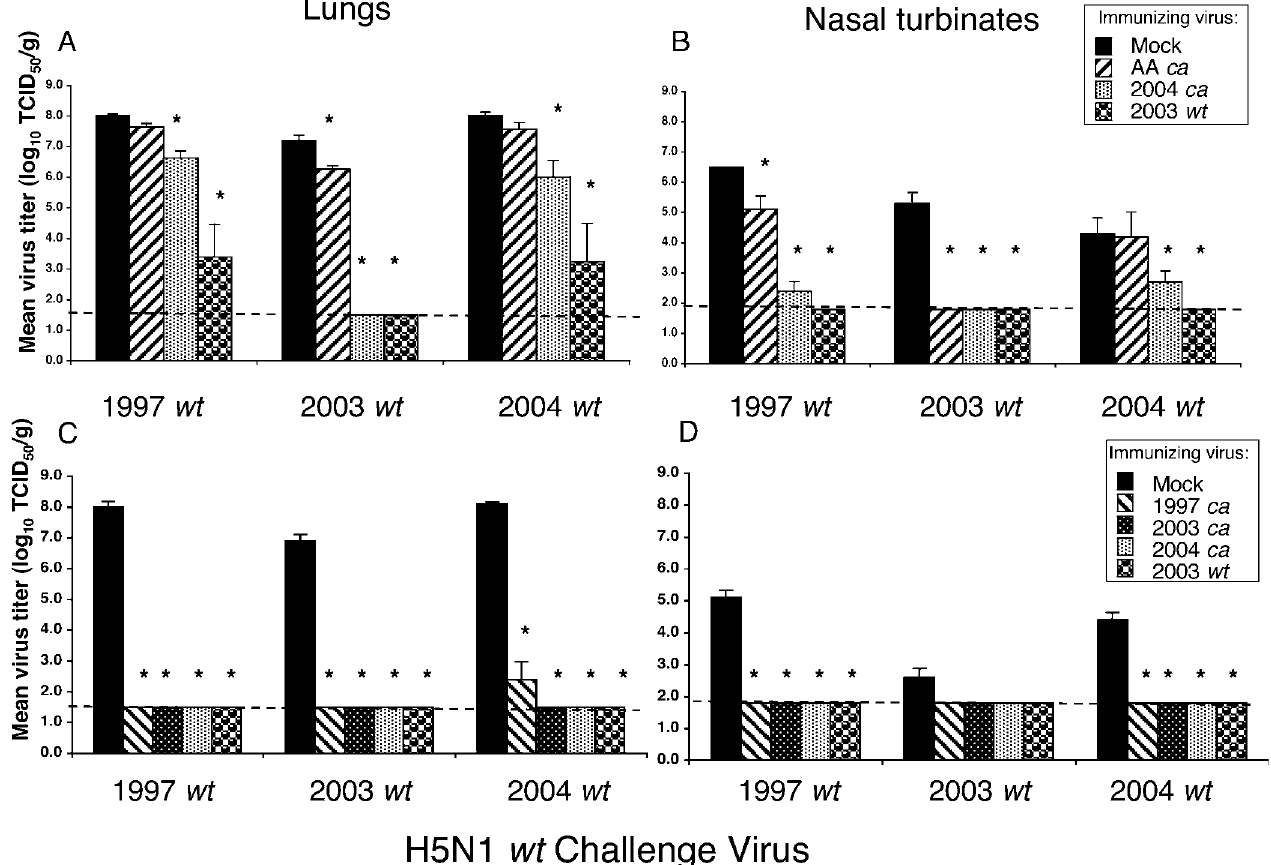
Figure 3. Replication of H5N1 wt Challenge Viruses in Mice Immunized with One or Two Doses of H5N1 ca Viruses (A and B) Mice that received a single dose of 10 6 TCID 50 of the immunizing virus were challenged with 10 5 TCID 50 of H5N1 1997 wt, H5N1 2003 wt, or H5N1 2004 wt viruses on day 28 p.i. Replication of challenge virus is shown in the lungs (A) and nasal turbinates (B). (C and D) Mice that received two doses of the immunizing virus 4 wk apart were challenged with the H5N1 wt viruses on day 56 p.i. Replication of challenge virus is shown in the lungs (C) and nasal turbinates (D). Lungs were harvested 2 d following challenge, homogenized, and titrated on MDCK cells. Groups of mock-immunized (L-15) mice and mice immunized with the nonlethal 2003 wt virus (single dose) or with AA ca were included as control groups. Four mice were evaluated in each group. The lower limit of detection is indicated by the dashed horizontal line. Log-transformed viral titers were compared using the Mann-Whitney U test. * p (cid:3) 0.05 compared to mock-immunized mice. DOI: